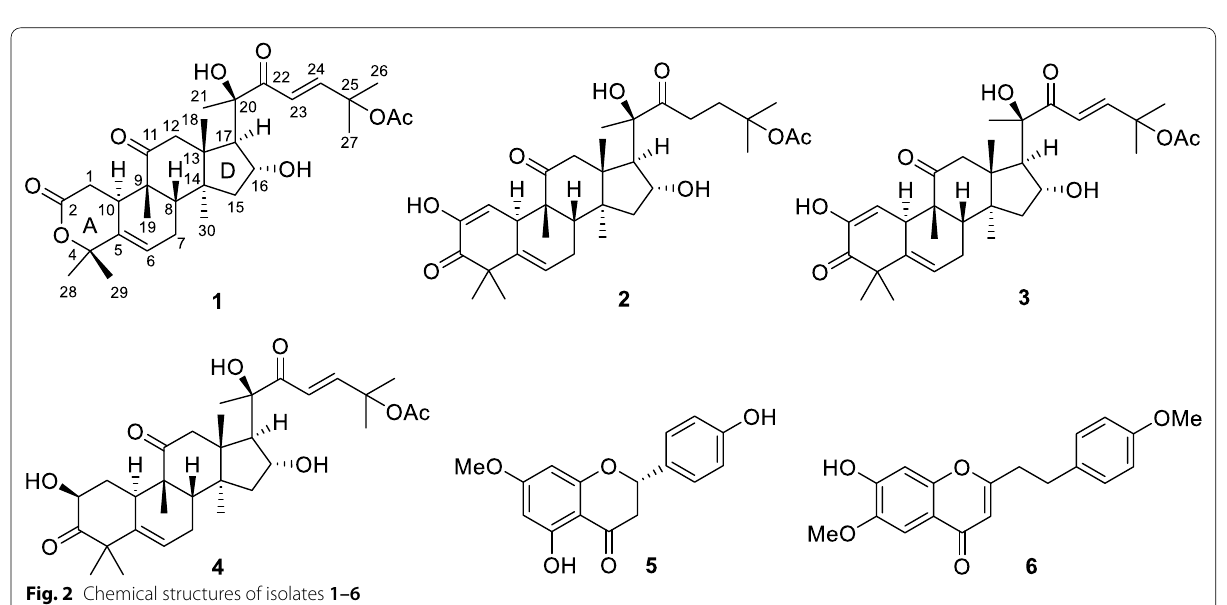
Fig. 2 Chemical structures of isolates 1–6